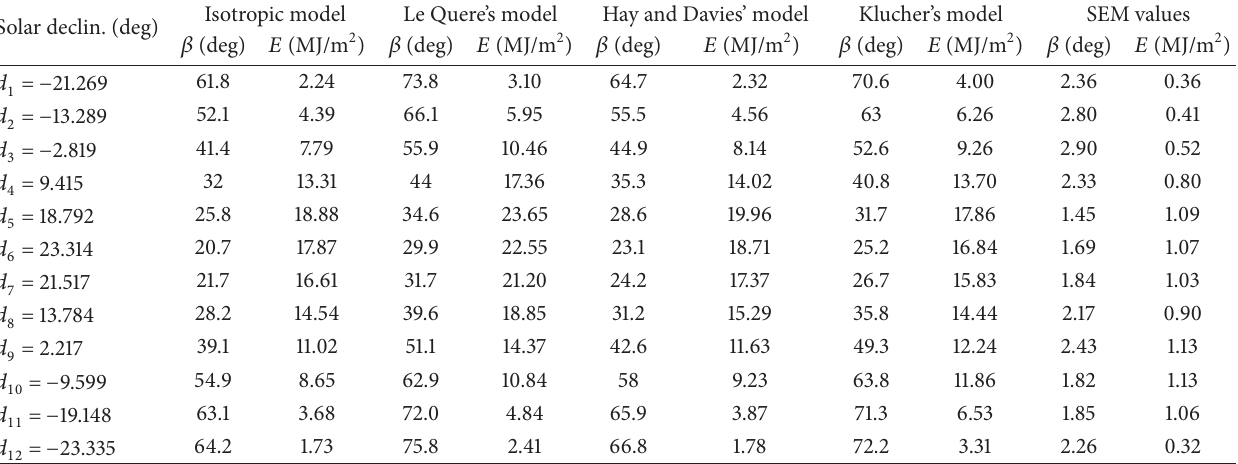
Table 5: Optimum tilt angle values and monthly mean of thedaily global solar radiation values computed by means of thealgorithm proposed inSection 2appliedtothemonthlyaveragesofthedailyglobalhorizontalsolarirradiationdataacquiredfrom1985to1989atthesiteofLondon (latitude +51 ∘ 32 󸀠 N; longitude 0 ∘ 05 󸀠 W).